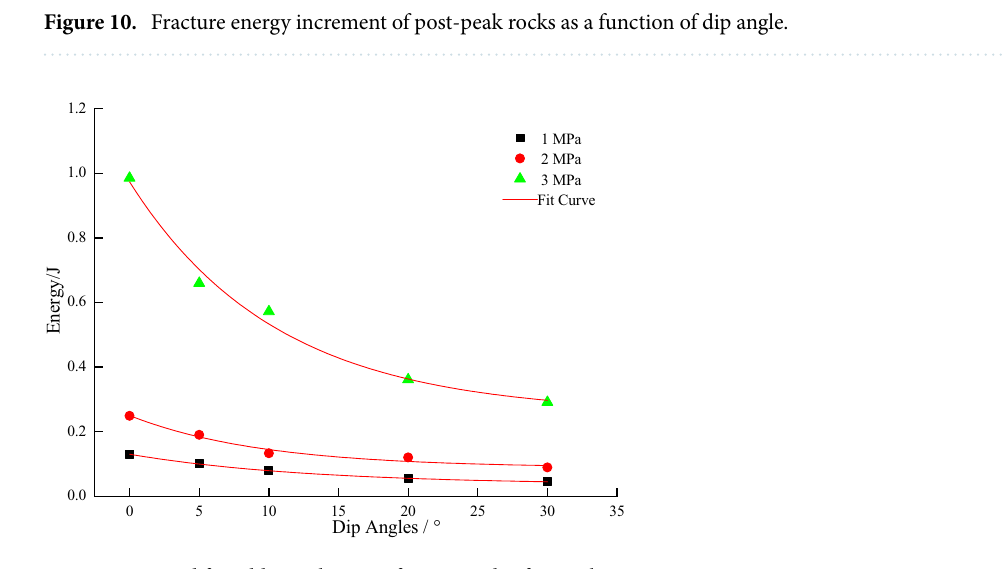
Figure 11. Need for additional energy from outside after peak